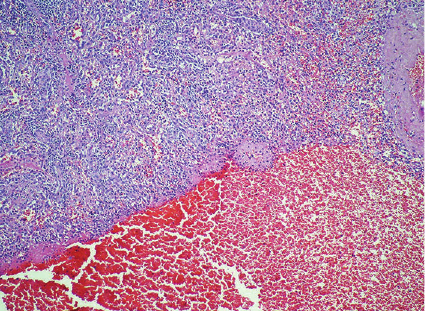
Figure 2: Eight centimeter mass inferior to the spleen. Figure 3: Hematoma including the accumulation of erythrocyte without epithelial lining in the lower half of